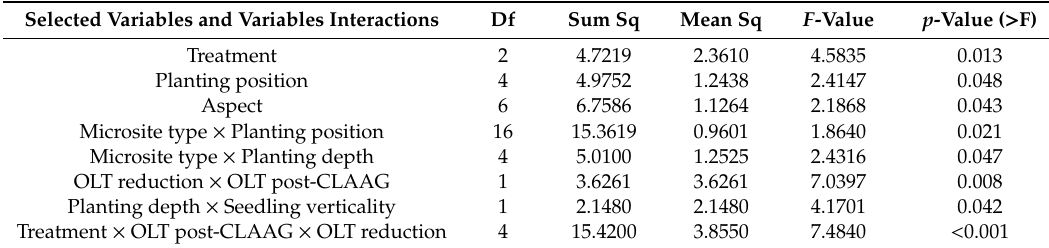
Table 1. Listing of variables and interactions selected by stepwise (backward-forward selections) composing the best mixed model. Summary of ANOVA results for the effect of selected variables and interactions on seedling relative growth rate in volume index (RGRV). The mixed effect model explained 49.7% of the variation in RGRV.